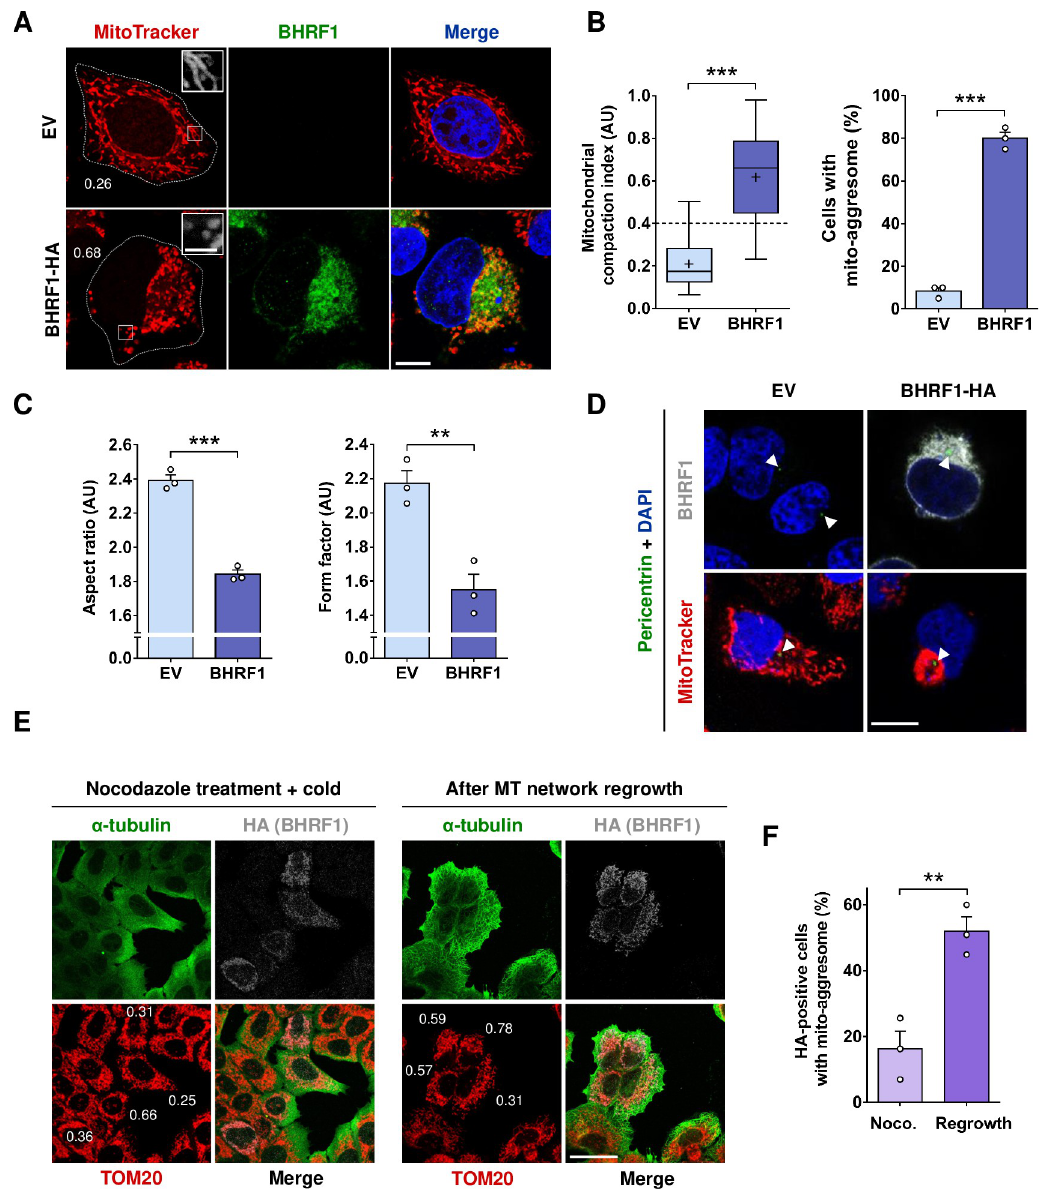
Fig 1. BHRF1 induces the formation of mito-aggresomes in a MT-dependent manner. (A-C) HeLa cells were transfected for 24 h with BHRF1-HA plasmid or with EV as a control. Mitochondria were labeled with MitoTracker and cells immunostained for BHRF1. Nuclei were stained with DAPI. (A) Confocal images with insets (3X) on mitochondrial phenotype. Values of mitochondrial CI are indicated on representative cells. Scale bars: 10 μ m and 2 μ m for insets. (B) Left , assessment of mitochondrial aggregation by calculation of CI. Right , percentage of cells presenting a mito-aggresome (n = 20 cells per condition). (C) Quantification of mitochondrial fission parameters, aspect ratio (AR; left panel ) and form factor (FF, right panel ). (D) Confocal images of HeLa cells transfected with BHRF1-HA plasmid (or EV) and immunostained for pericentrin and BHRF1 ( upper panel ) or mitochondria ( lower panel ). Nuclei were stained with DAPI. Scale bar: 20 μ m. Arrowheads show the centrosomal localization of pericentrin. (E-F) MT network depolymerization assay. (E) Representative images where BHRF1 expression was visualized by HA immunostaining (gray), the MT network by α -tubulin immunostaining (green), and mitochondria are immunostained with an anti-TOM20 antibody (red). Values of mitochondrial CI are indicated on representative cells. Scale bars: 10 μ m. (F) Percentage of BHRF1-HA-positive cells presenting a mito-aggresome (n = 30 cells per condition) in cells treated with nocodazole and after MT regrowth. Data represent the mean ± SEM of three independent experiments. �� P < 0.01; ��� P < 0.001 (Student’s t-test).